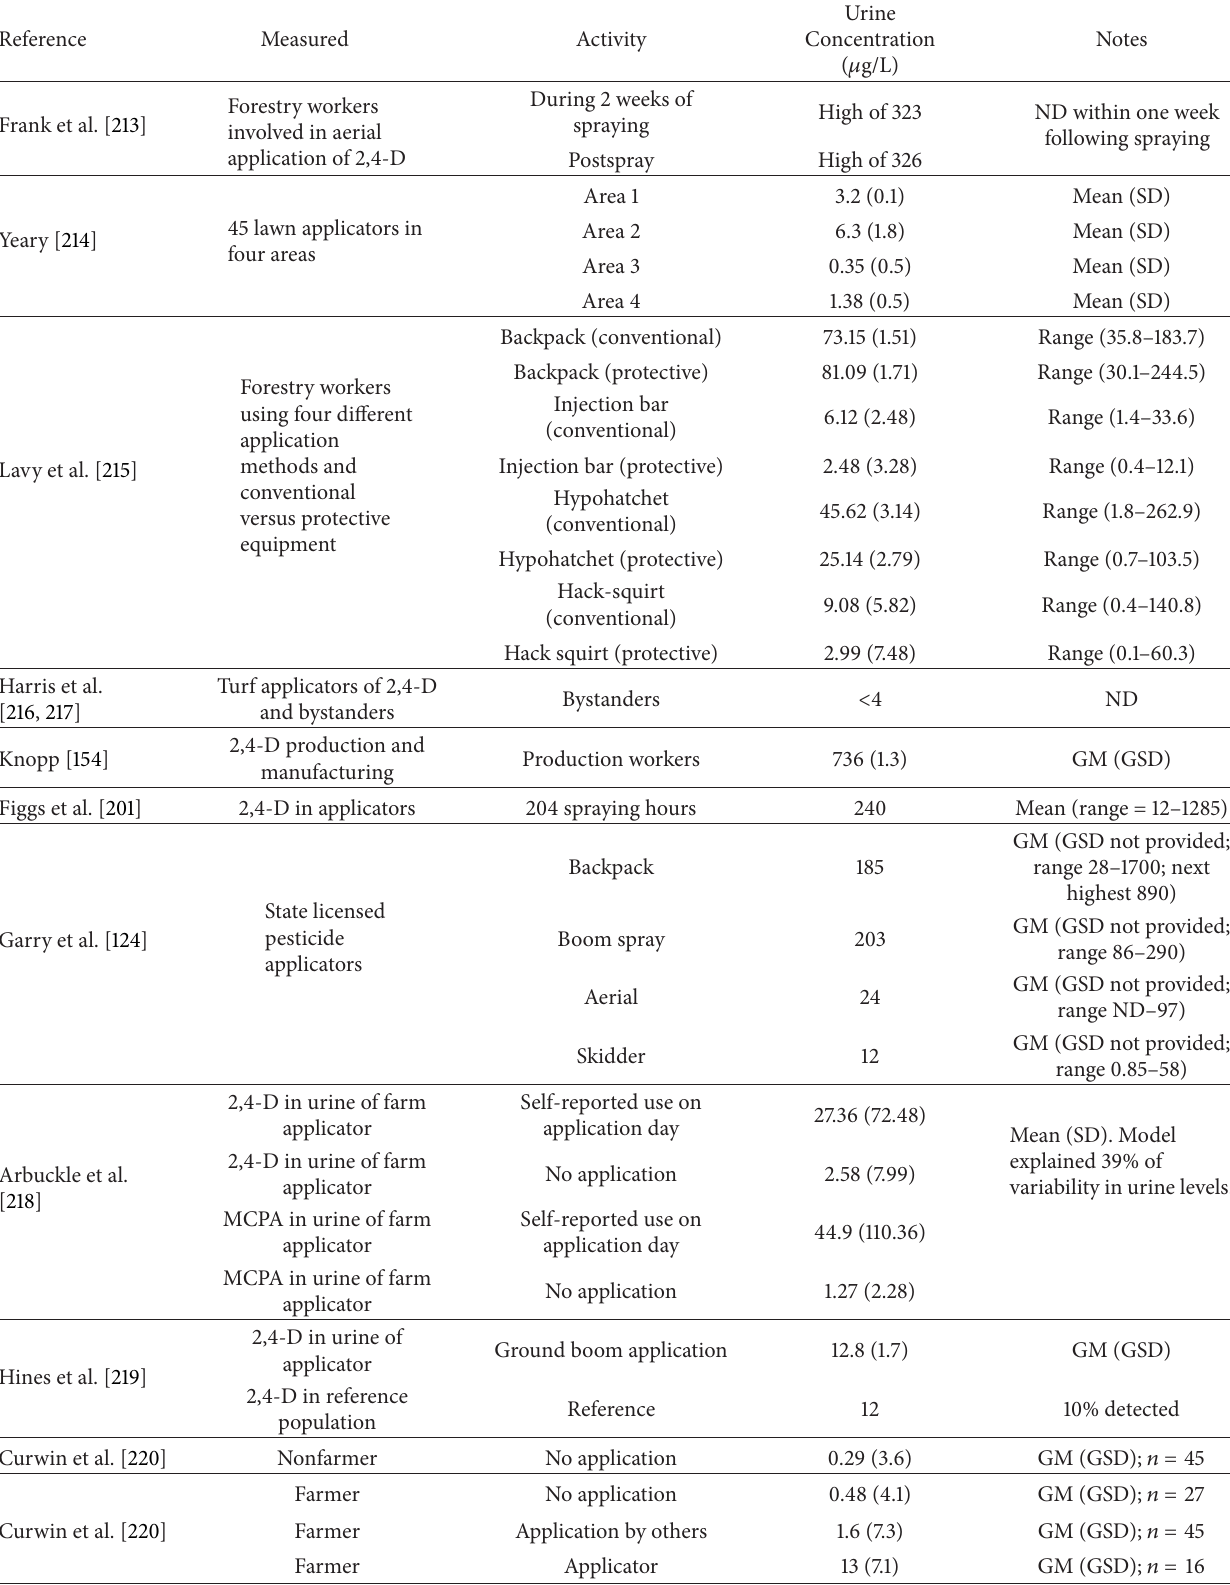
Table 10: Summary of biomonitoring